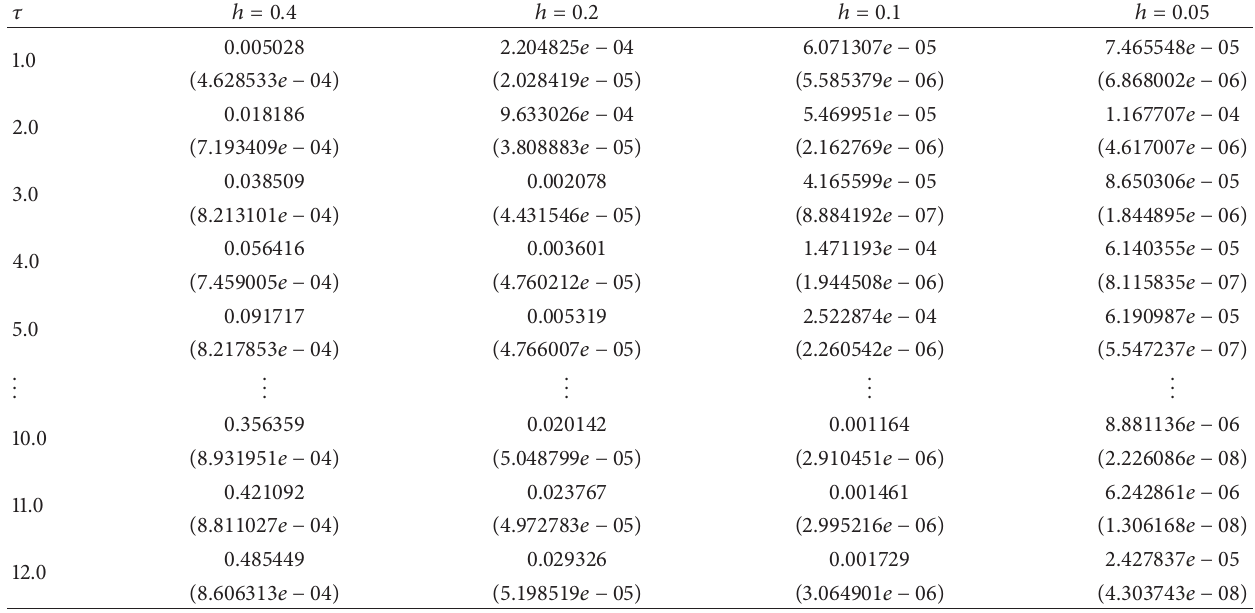
Table 1: Errors of the OSC scheme for Example 1 with 𝜏 = 0.01 .